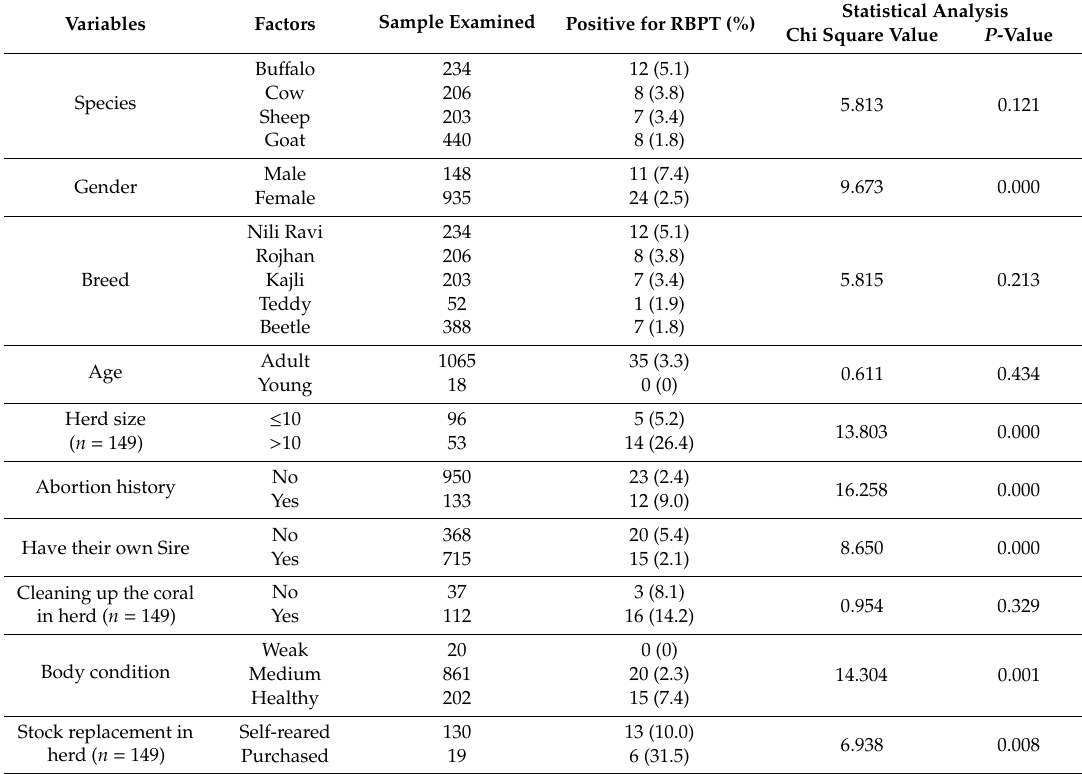
Table 3. Risk factors associated with ovine, caprine, and bovine brucellosis in the four districts of Punjab, Pakistan, on the basis of Chi square